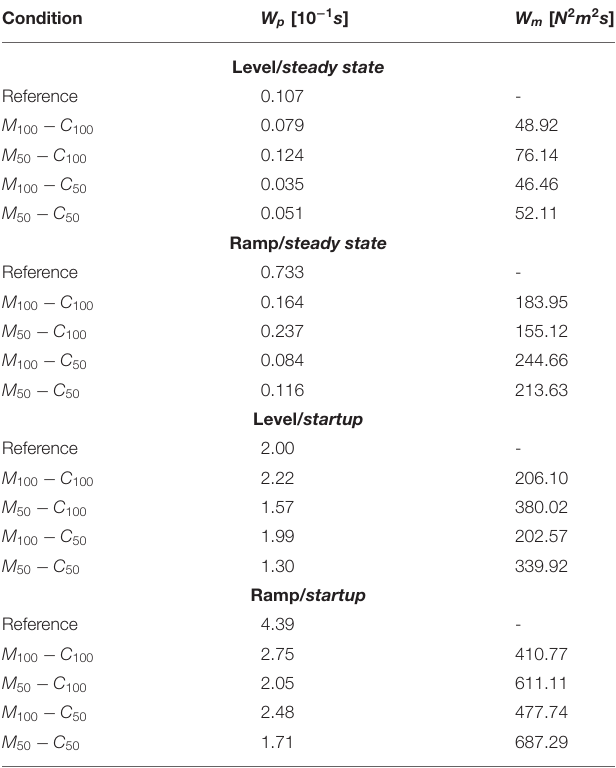
TABLE 4 | Predicted user effort W p (Equation 9) and motor effort W m (Equation 10) for all simulated conditions.